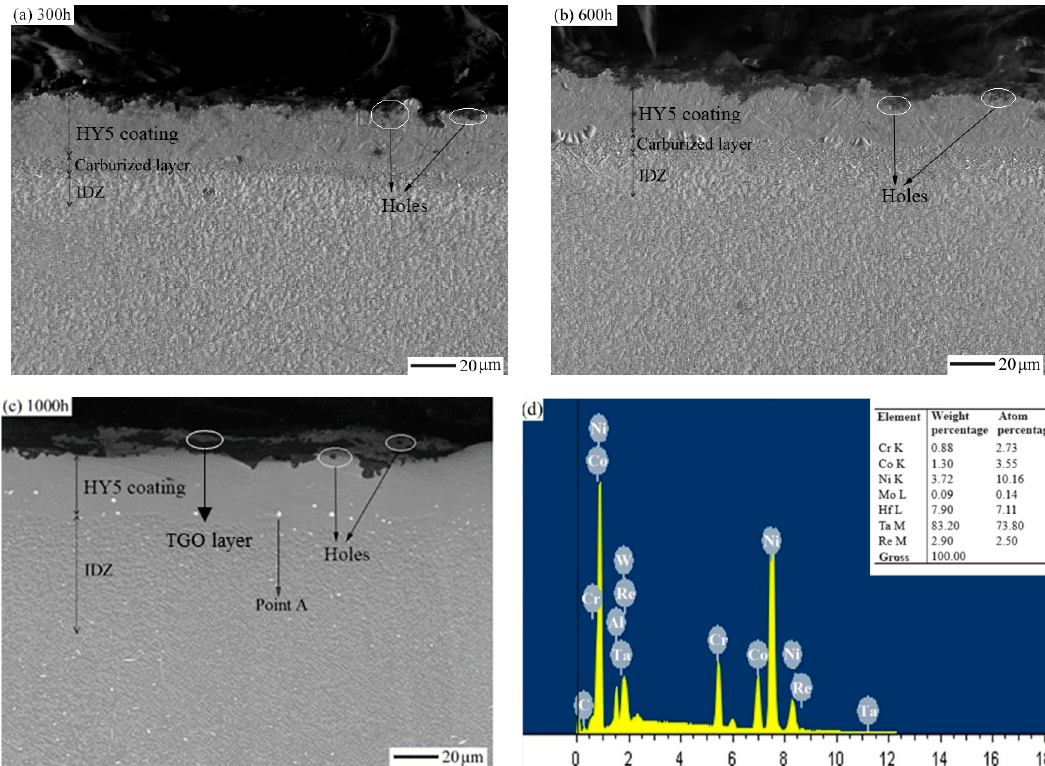
Figure 6. Backscatter-Electron (BSE) images of the cross-sectional morphologies of the carburized Ni-based single-crystal superalloy with HY5 coatings after thermal cyclic oxidation at 1100 °C for different oxidation times: ( a ) 300 h; ( b ) 600 h; ( c ) 1000 h. ( d ) EDS spectra of point A in ( c ).